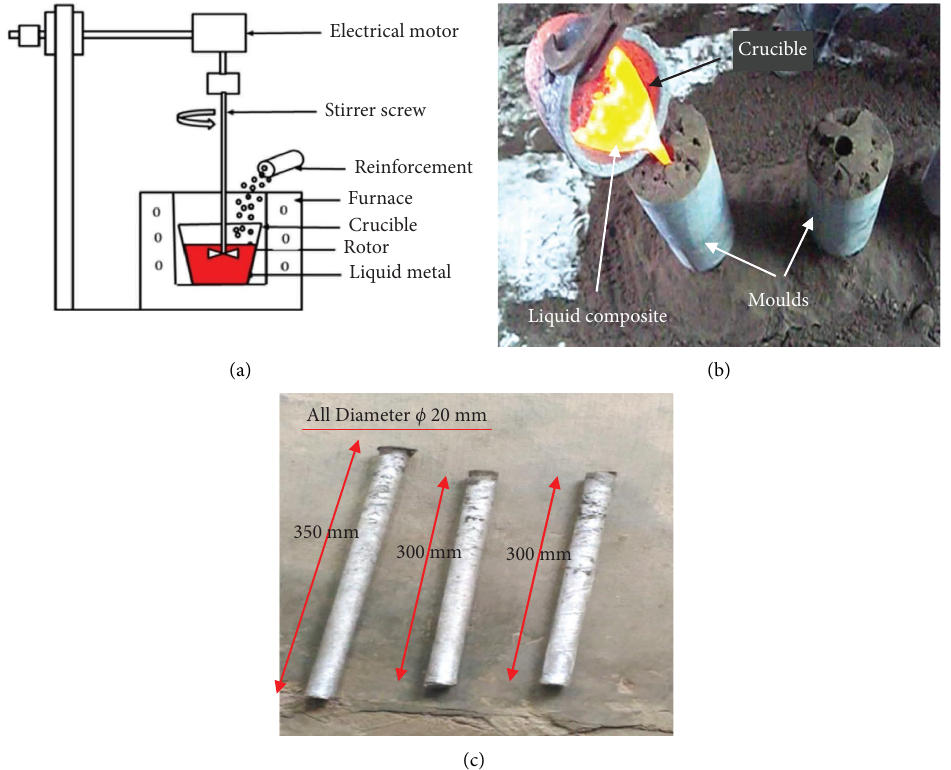
Figure 1: (a) Schematic of stir casting; (b) composite pouring; (c) prepared composite